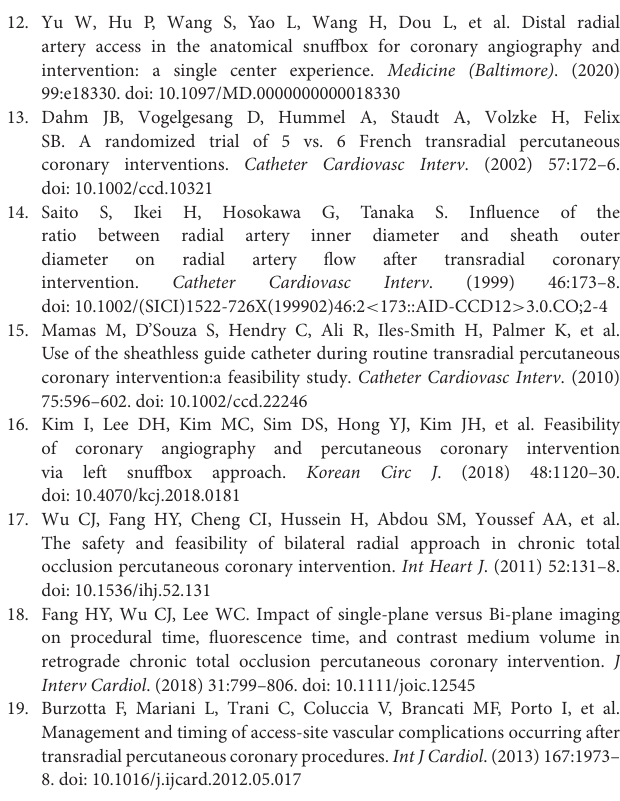
Supplementary Figure 1 | Demonstration of the bilateral snuffbox approach. A 7-F Glidesheath via the left snuffbox and a 7-F standard sheath via the right